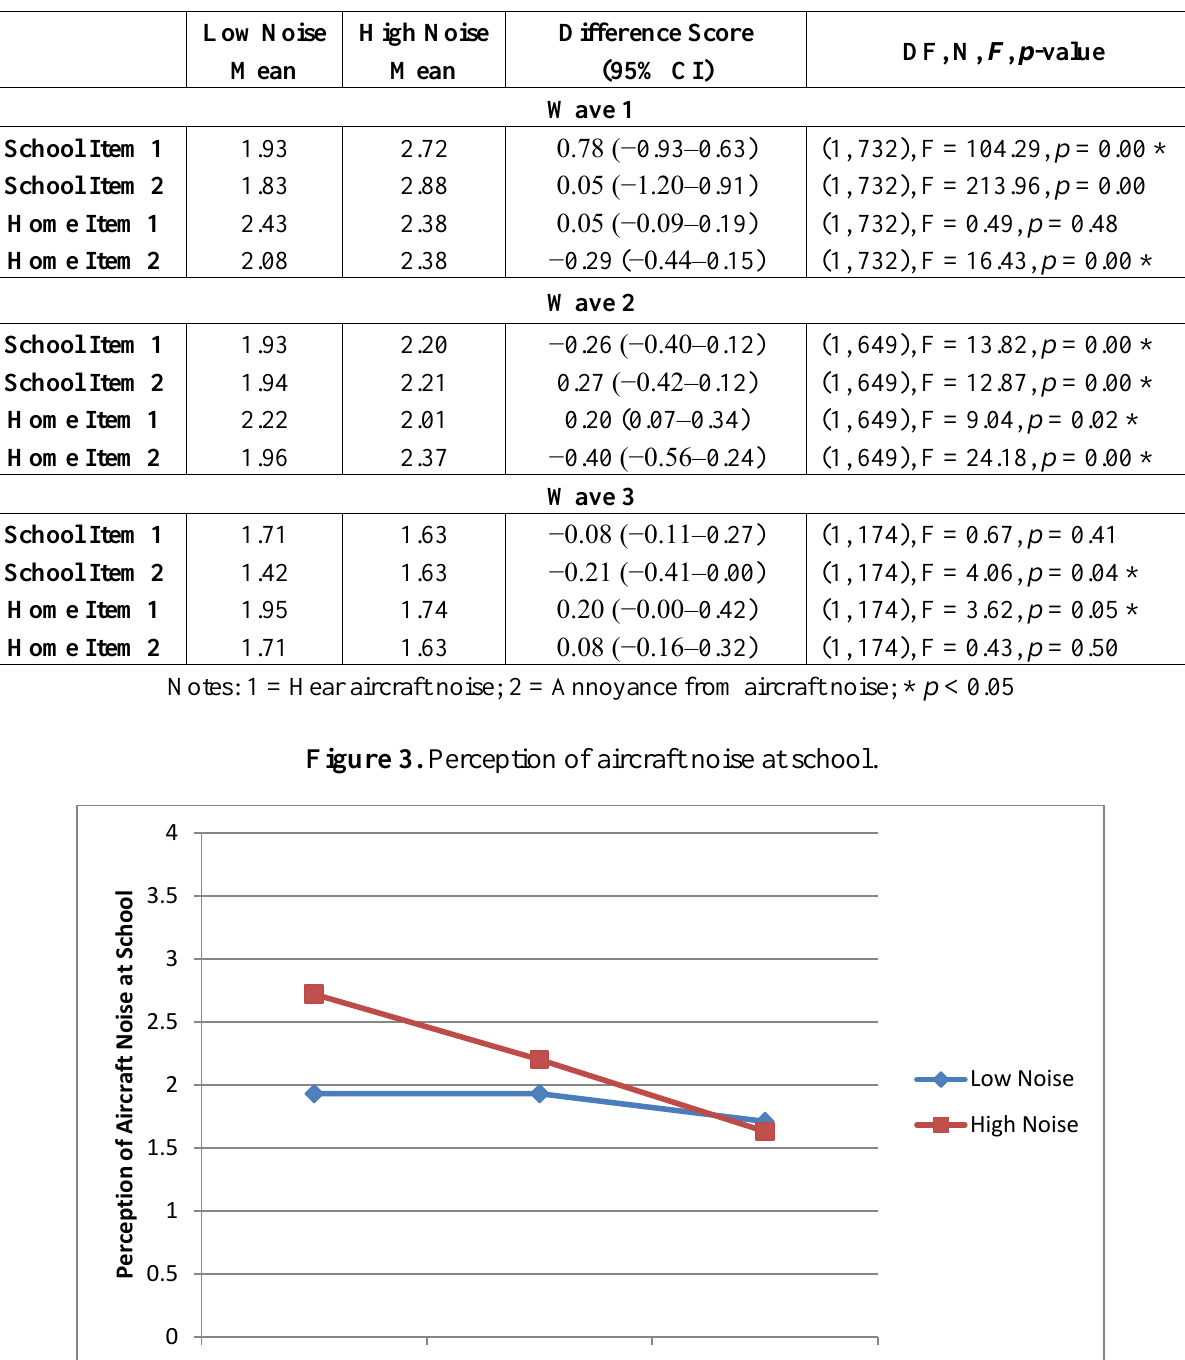
Table 2. Perception of noise at school and home.